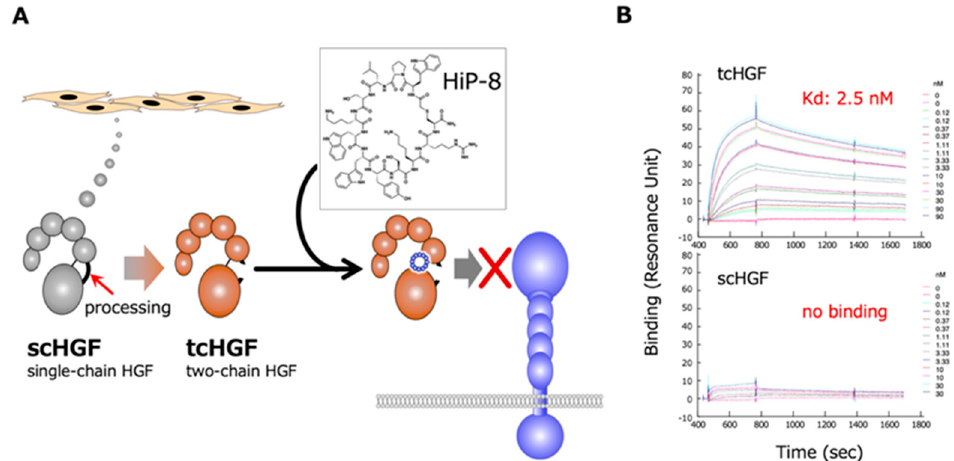
Figure 3. Outline of the action of HiP-8 ( A ) and the selective binding of HiP-8 to two-chain active HGF ( B ). Once HiP-8 binds to tcHGF, tcHGF cannot bind to MET ( A ). The sensorgram shows that HiP-8 selectively binds to tcHGF, but not to scHGF ( B ) [20].